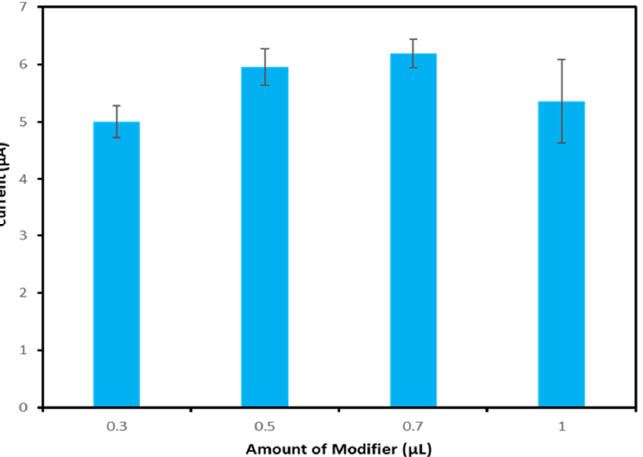
Figure 7. Bar chart of DPV oxidation peak current of E2 vs. the amount of rGO-AuNPs/CNT modi- fier.